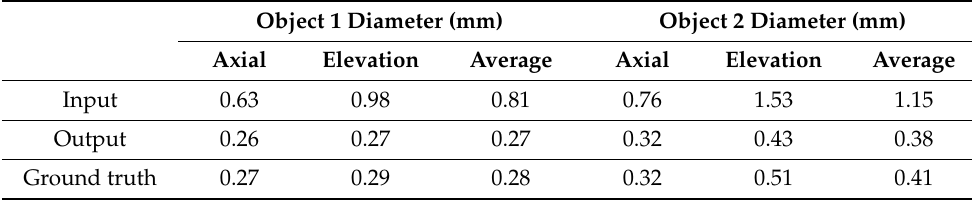
Table 2. Diameter quantification along axial and elevation directions of simulated vasculature.